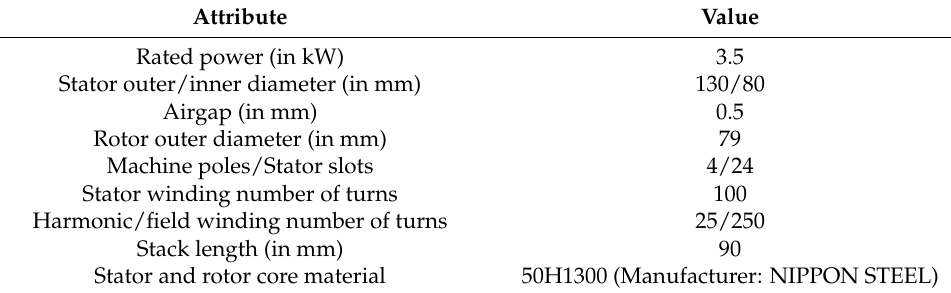
Table 1. Specifications of the investigated